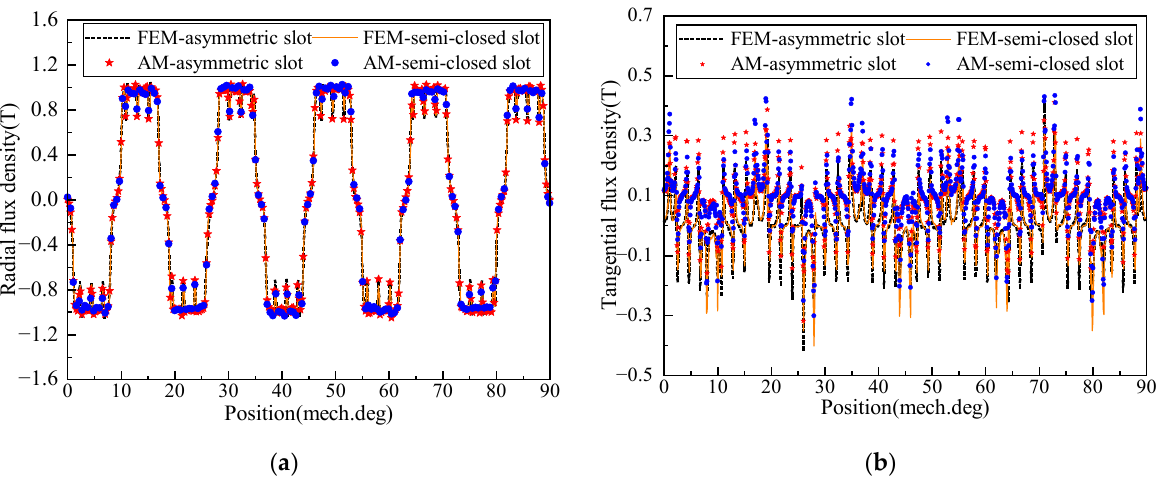
Figure 8. Air gap flux density of semi-closed slot model and asymmetric slot model: ( a ) radial; ( b ) tangential.